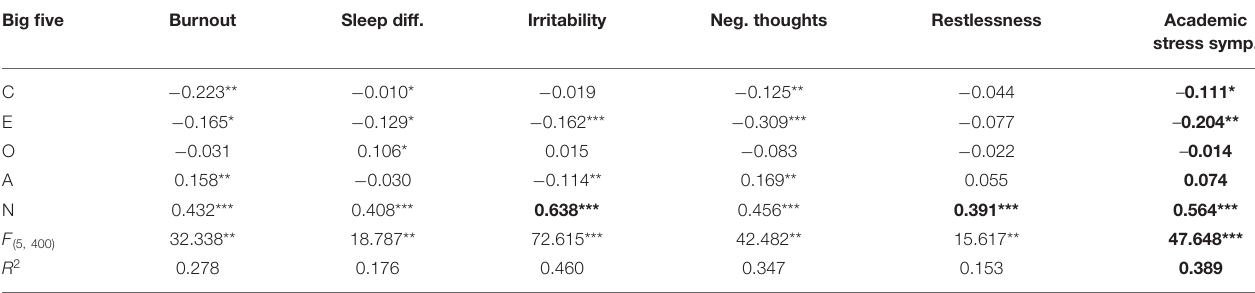
TABLE 4 | Multiple regression between the BF factors, and symptoms of academic stress ( n = 405). Big five Burnout Sleep diff. Irritability Neg. thoughts Restlessness Academic